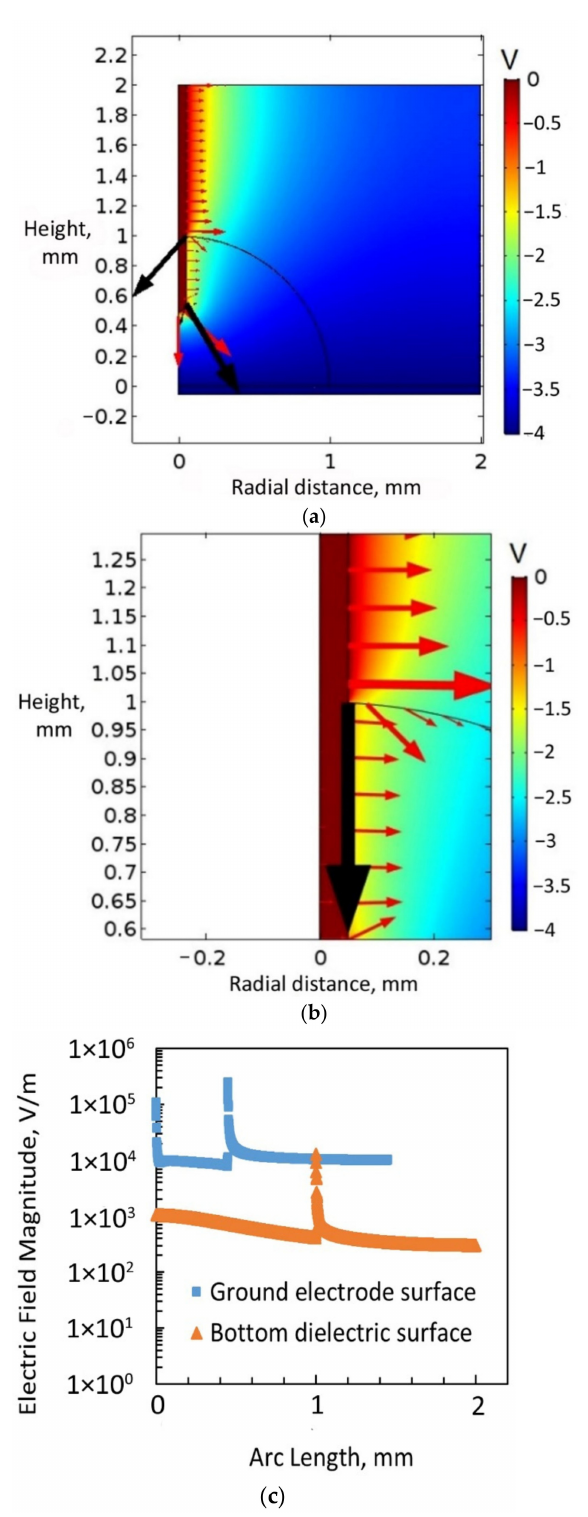
Figure 11. ( a ) Electric field simulation considering water to be a leaky dielectric and a dielectric- coated ground electrode exposed to a sessile water drop, with 4 V applied to the bottom electrode covered with a dielectric. ( b ) Magnified view of the simulation result representing the vertical force component (the black arrow line) on the ground electrode. ( c ) Electric field magnitude on the dielectric-coated ground electrode surface and bottom dielectric